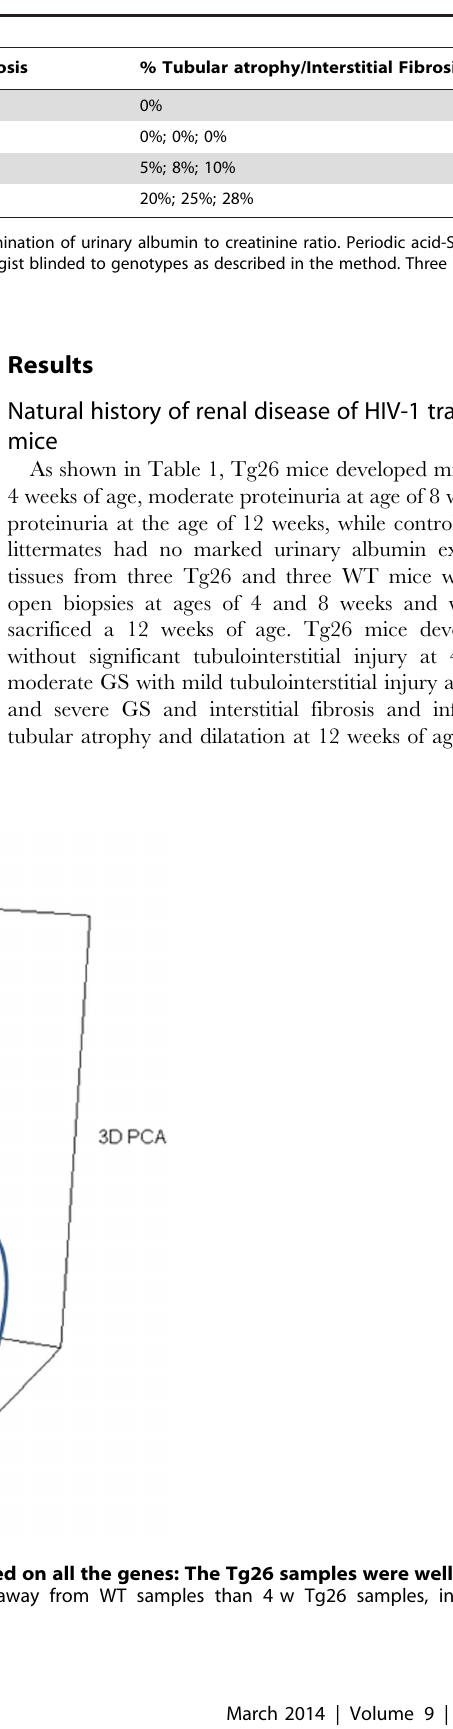
Table 1. Proteinuria and histology of Tg26 mice at three time points.